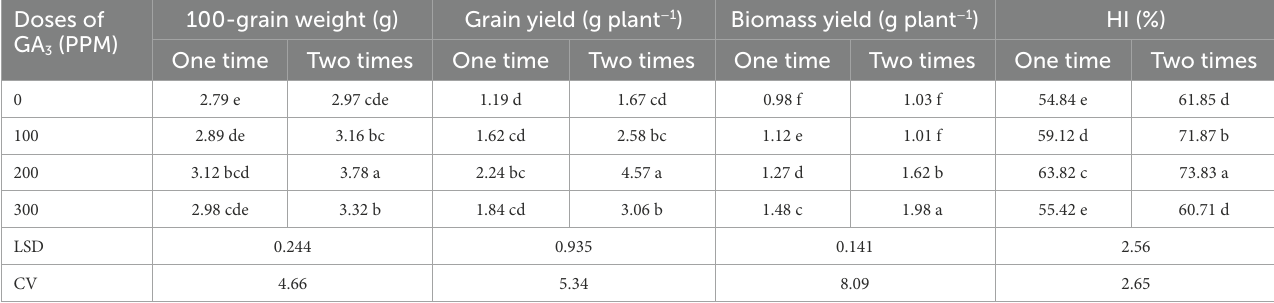
TABLE 6 The 100-grain weight, grain and biomass yield, and harvest index of mungbean in response to foliage applied GA 3 in varying concentrations and frequencies. Doses of GA 3